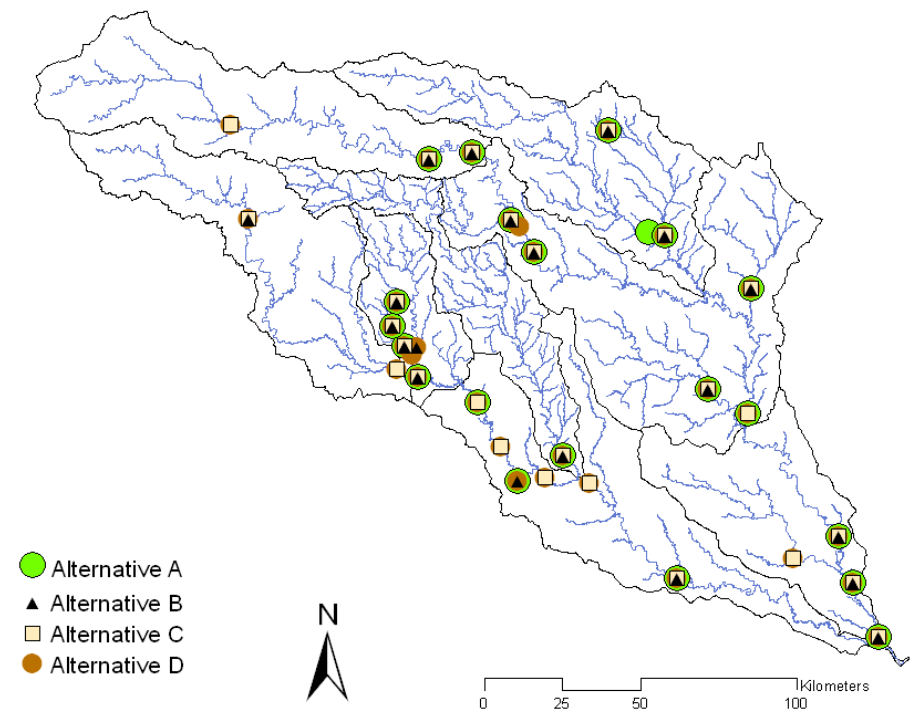
Figure 3. Four alternative sets of monitoring stations obtained after the application of the modified MOEA.